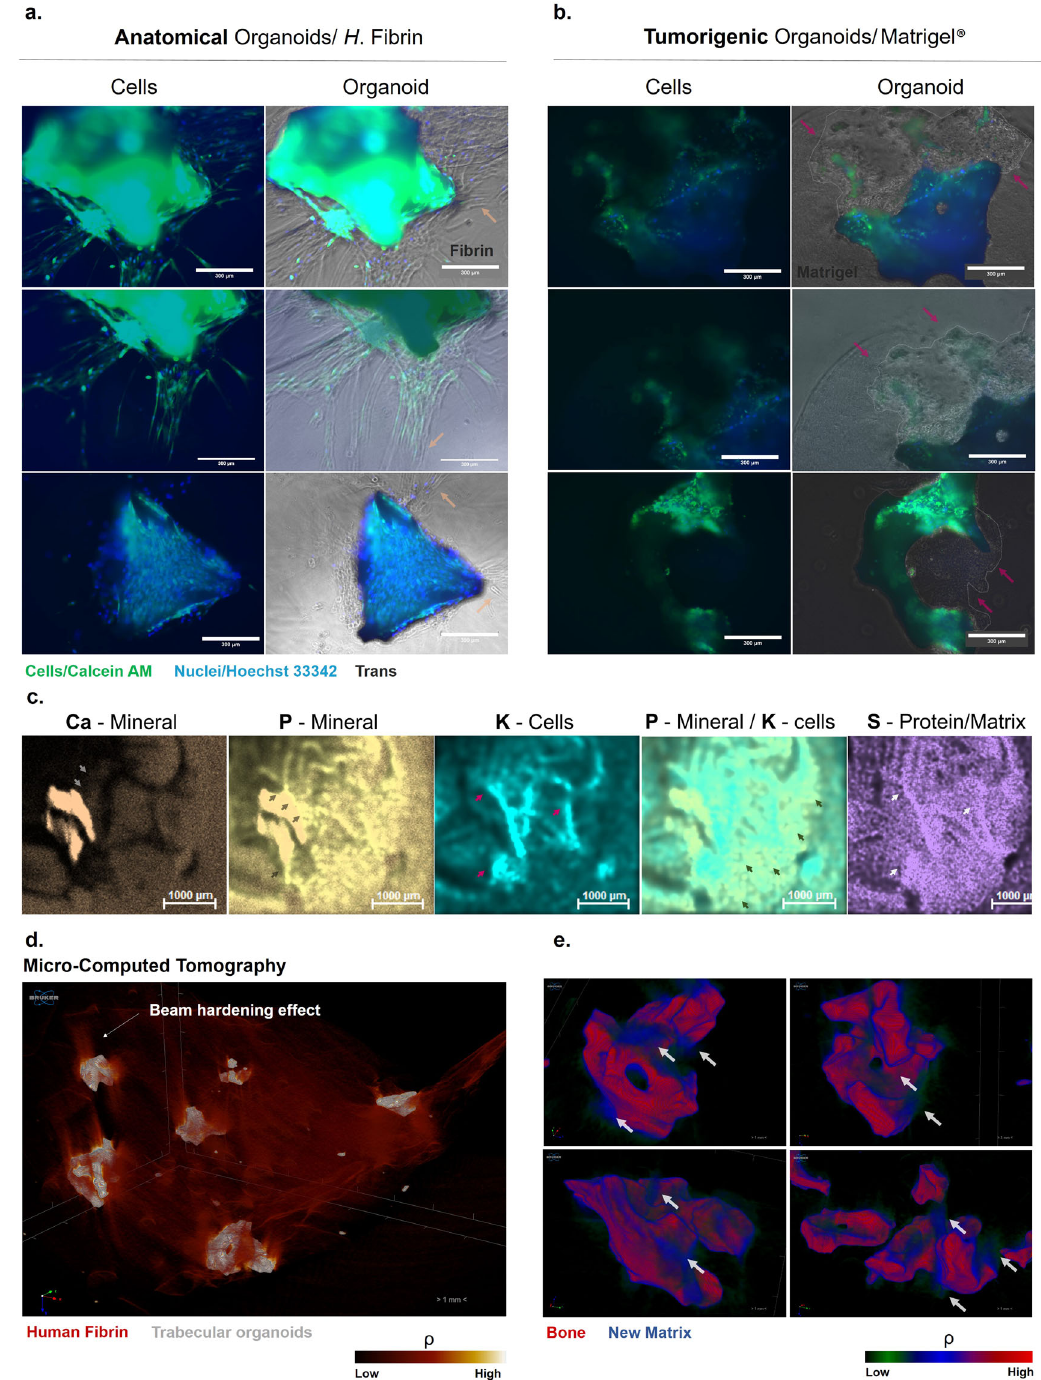
structure in both conditions (panel e). To illustrate differences that can be assessed in these constructs, two examples were provided for morphological comparison at an individual construct level in Fig. 7e. These include a construct in the normal gravity condition (top) that contains a higher number of projections compared to a simulated microgravity-cultured construct (bottom), which con- tains a main tubular structure forming into the matrix, but which displays many possible emerging structures, based on the distribution of potassium (K), in network-like arrangements surrounding the initial